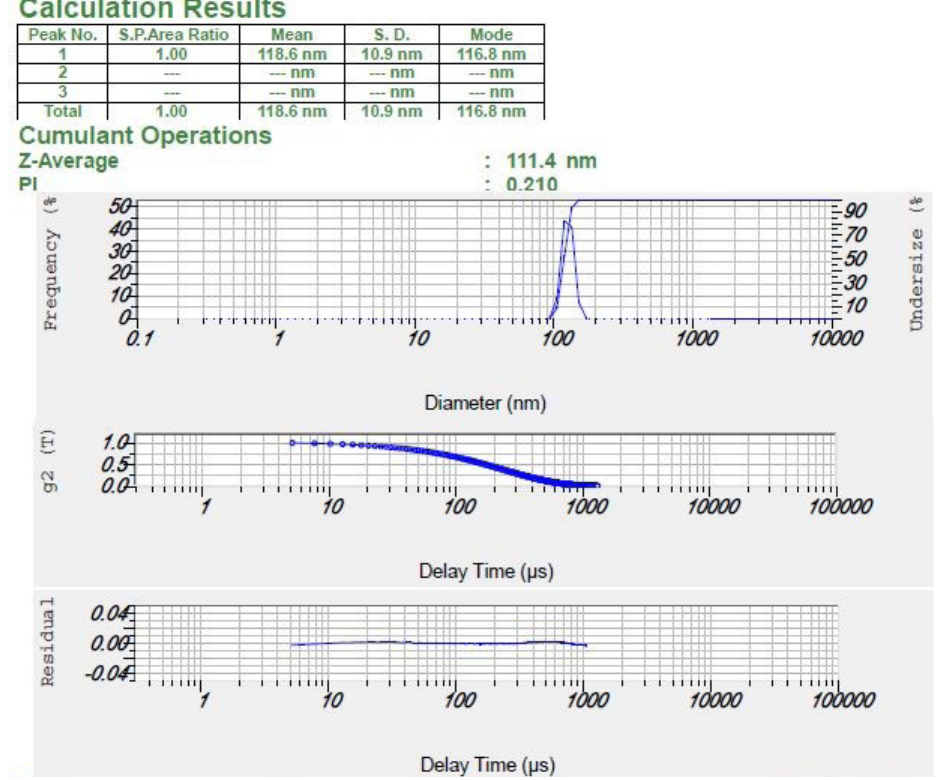
Figure 5. Lipid Nanoparticles Size Obtained From the DLS Device. Note . DLS: